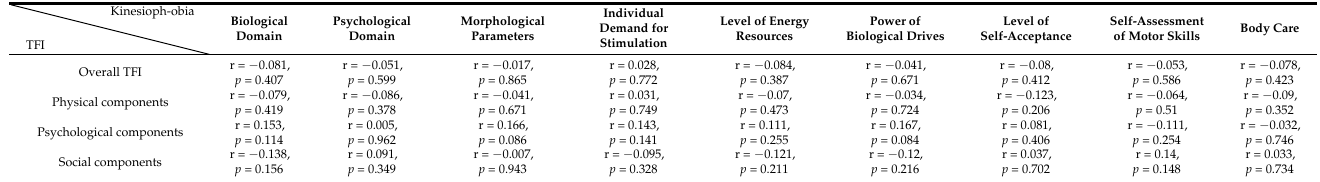
Table 4. Correlations between the Tilburg Frailty Indicator (TFI) subscale and kinesiophobia.